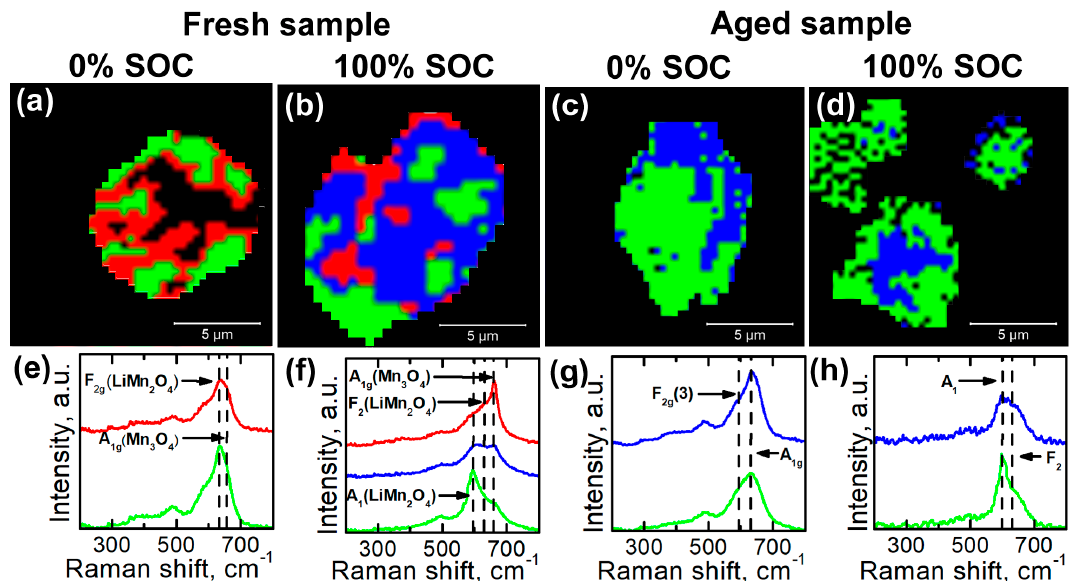
Figure 6. Cluster analysis of CRM images for LMO particles with different SOH and SOC. ( a , b ) lithiated and delithiated state for aged cathodes; ( c , d ) lithiated and delithiated state for fresh cathodes. Blue color: higher lithiated state, green color: less lithiated state, red color: Mn 3 O 4 ; ( e – h ) Averaged Raman spectra from selected clusters with marked vibration modes corresponding to upper images. Dashed lines identify major lines in spectra related to ‘state of charge’ and Mn 3 O 4 phase.